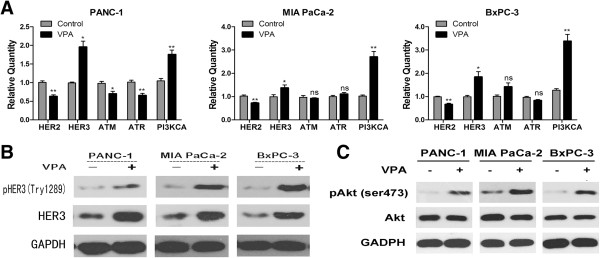
VPA activates the PI3K/Akt signaling pathway in pancreatic cancer cells. Pancreatic cancer cells were incubated with or without 1 mM VPA for 24 h. (A) Quantitative real-time RT-PCR analysis of HER2, HER3, ATM, ATR, and PI3KCA mRNA expression in PANC-1, MIA PaCa-2 and BxPC-3 cells. Data are mean ± SD of a single experiment performed in triplicate, all results were reproducible in three independent experiments. ns P > =0.05; * P < 0.05; ** P < 0.01. (B, C) Western blotting analysis of the expression and phosphorylation of HER3 and Akt (ser 473).